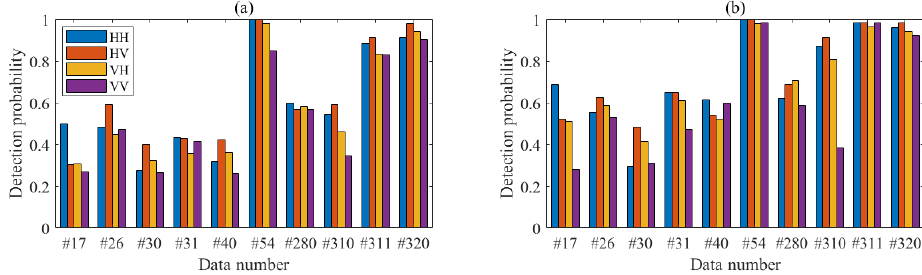
Figure 5. Detection probability contrasts of FAST four-feature detection at four polarizations, when ( a ) N = 512, ( b ) N = 1024 and P fa = 10 − 3 .